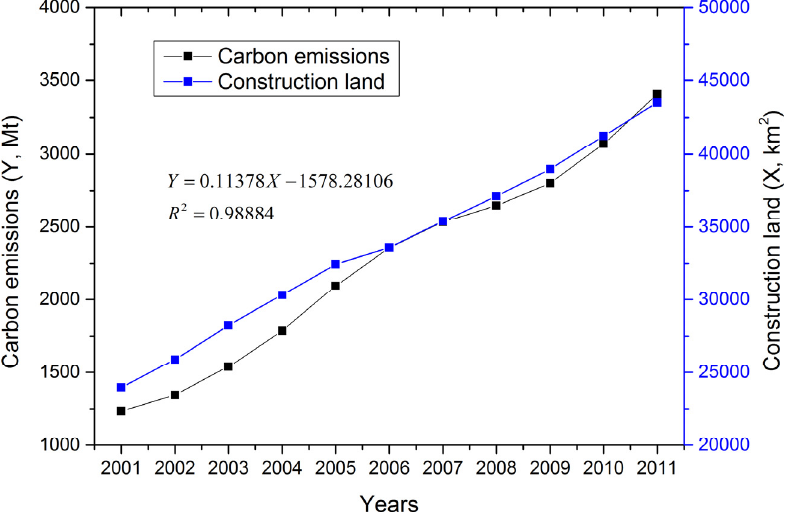
Figure 2. Change characteristics of carbon emissions and construction land in